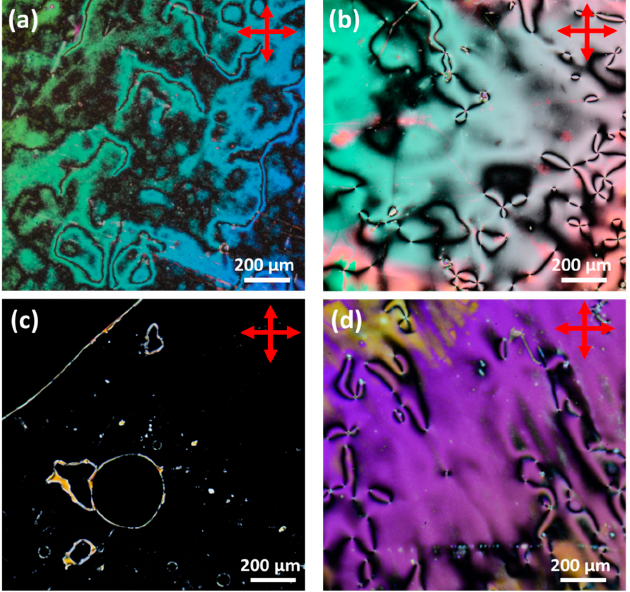
Figure 5. Transmission POM images of LCs confined between cleaned glass substrates. ( a ) E7, ( b ) MLC2081, ( c ) MLC6609 and ( d ) MLC7023.